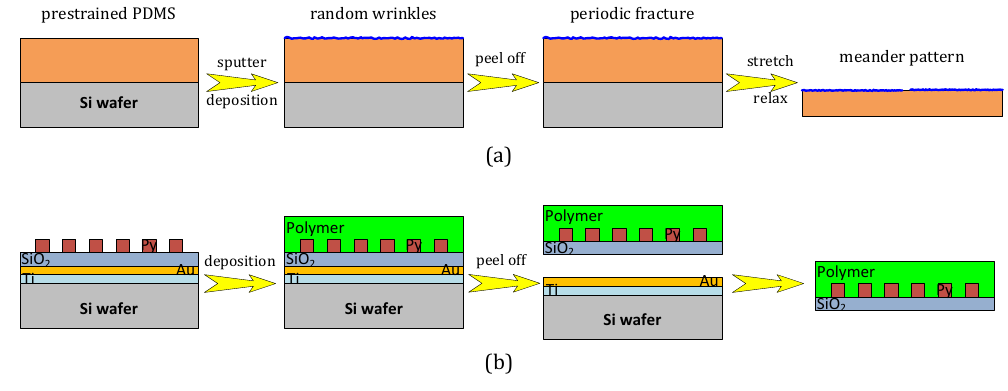
Figure 5. Different approaches for obtaining GMR structures onto flexible substrates: ( a ) as described in [19]; ( b ) as described in